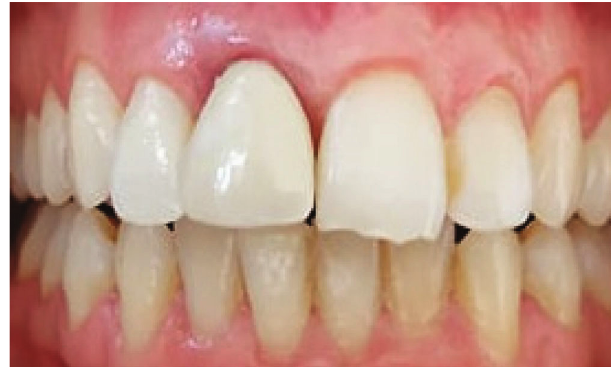
Figure 3: Initial situation: The upper right central incisor is crowned and displays triangular shape.